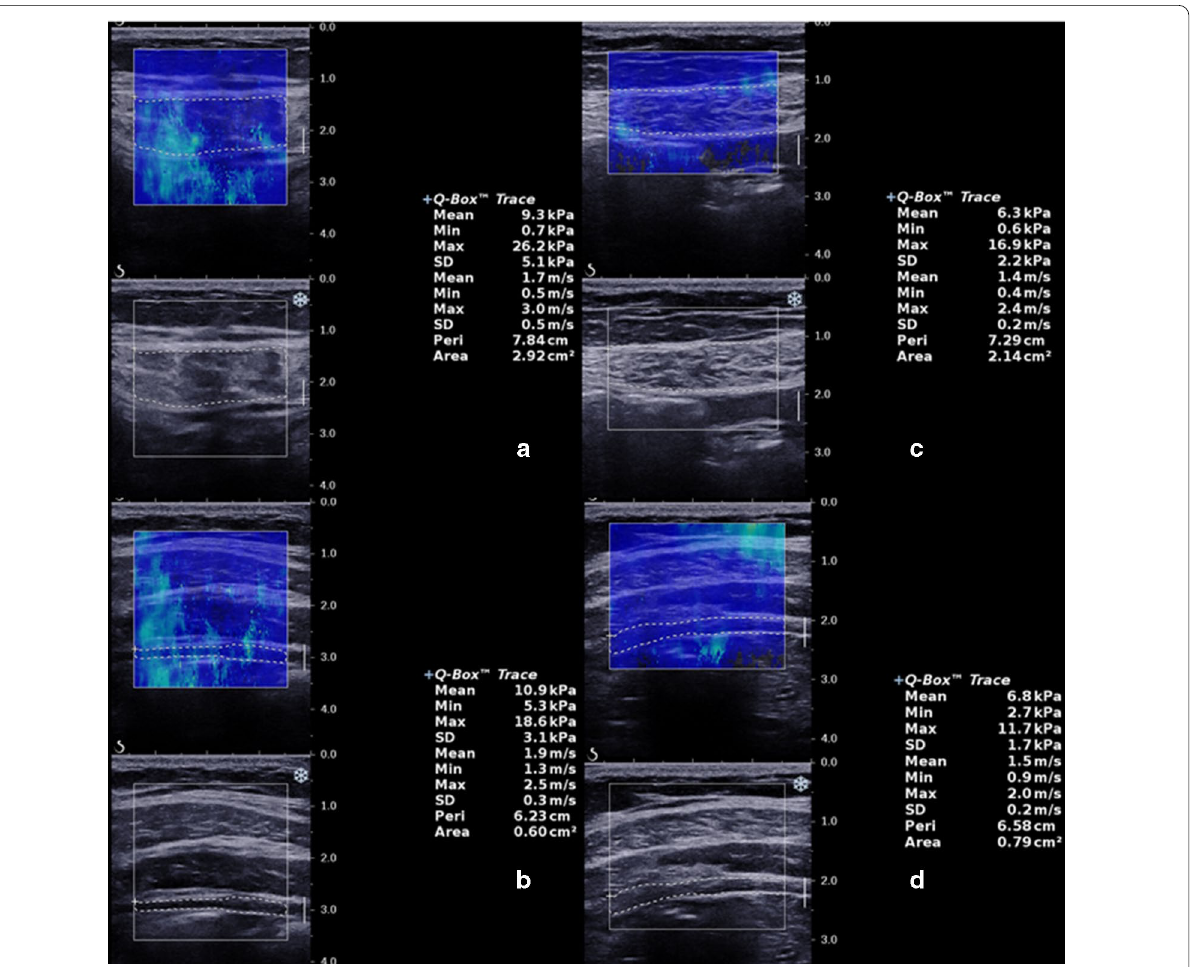
Fig. 8 Shear wave elastography of patients with DRA. One forty-year-old patient with inter-rectus distance of 5.12 cm showed higher shear wave speed in RA and TrA ( a 1.7 m/s, b 1.9 m/s). Comparatively, another thirty-two-year-old patient with inter-rectus distance of 3.36 cm exhibited lower shear wave speed in RA and TrA ( c 1.4 m/s, d 1.5